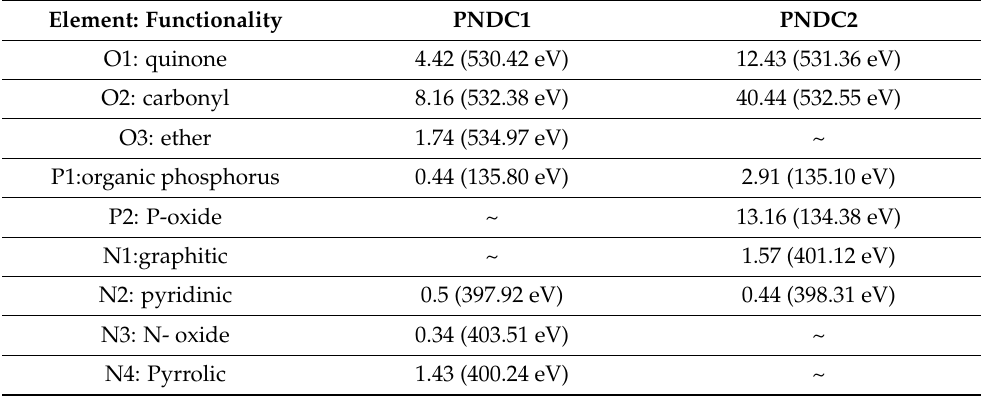
Table 4. Detailed narrow scan XPS analysis of functionalities on PNDC surfaces. (At